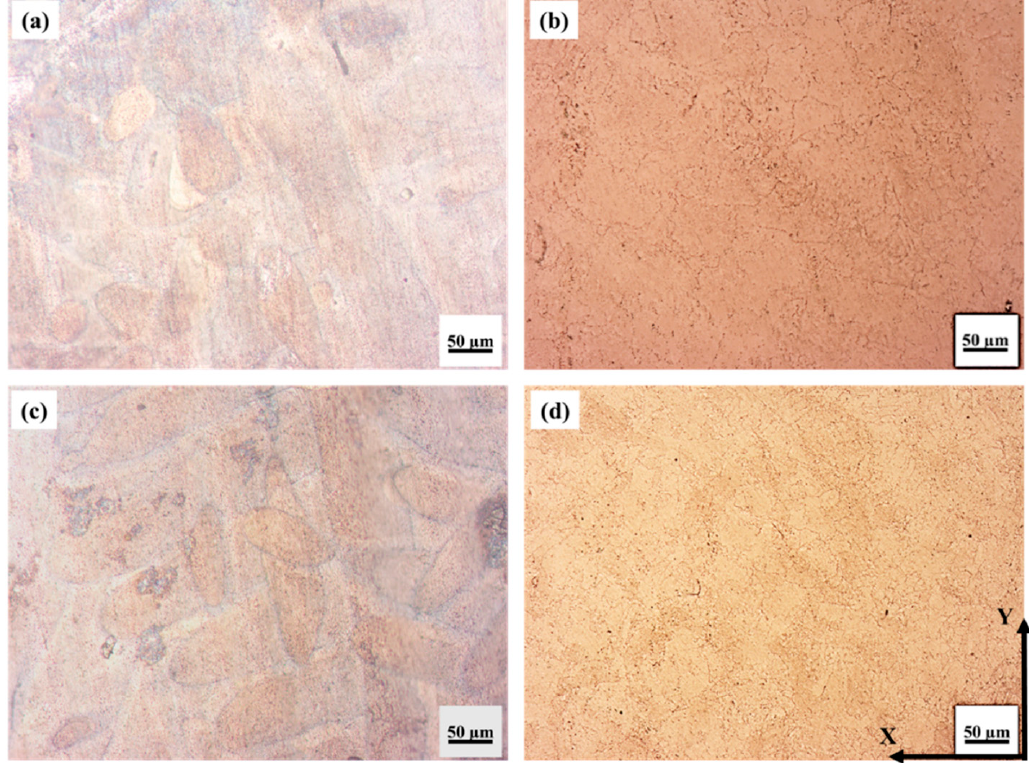
Figure 2. Optical microstructure on XY plane in the ( a ) as-built material (AB), ( b ) heat-treated as-built material (HT), ( c ) shot-peened as-built material (SP), and ( d ) heat-treated and shot-peened as-built material (HTSP).